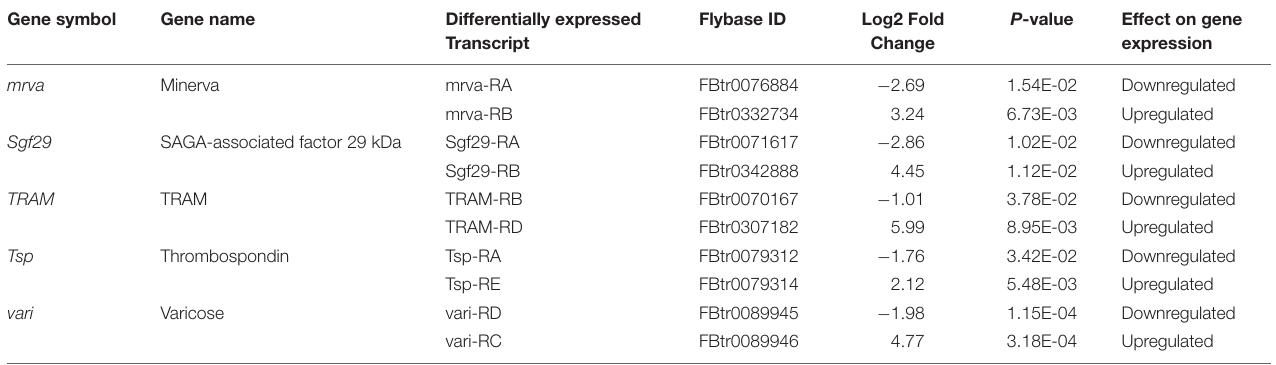
TABLE 1 | Genes with transcripts showing opposing alcohol-induced